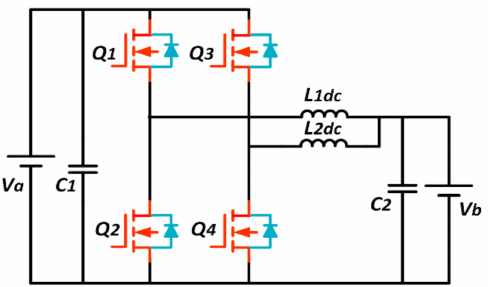
Figure 9. Two-phase interleaved half-bridge bidirectional DC/DC converter [54].